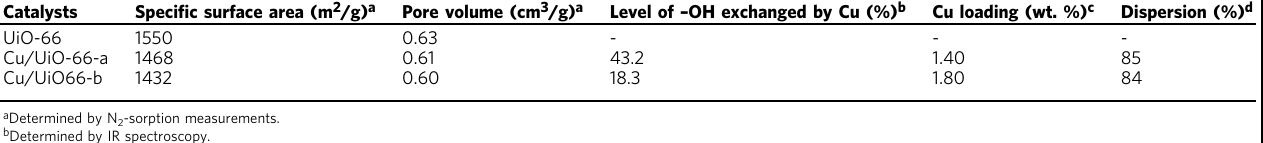
Table 1 Textural properties of selected materials, level of – OH groups exchanged, Cu content in the modi fi ed MOFs, and dispersion of the Cu